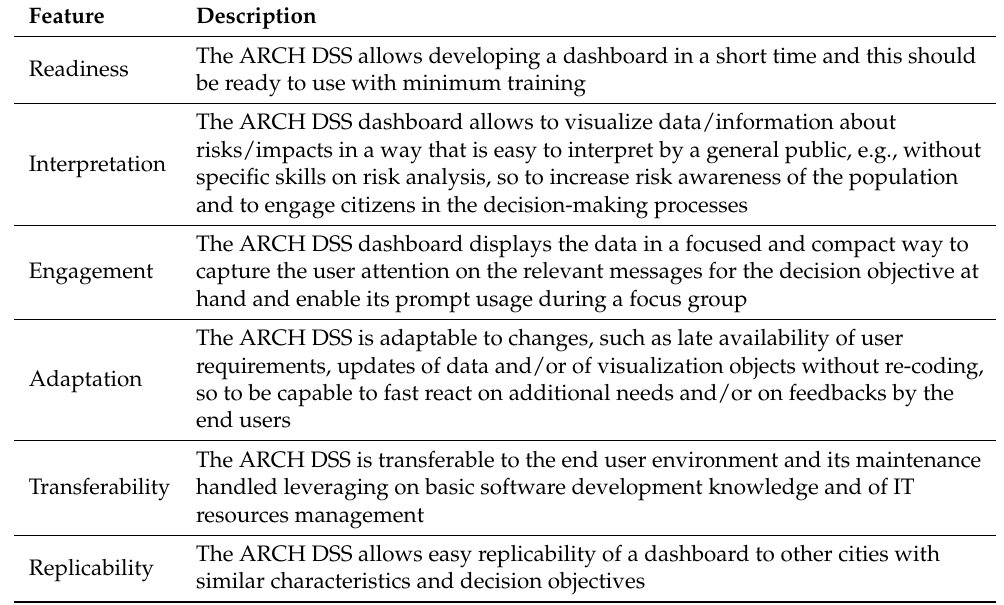
Table 1. Features of the ARCH DSS